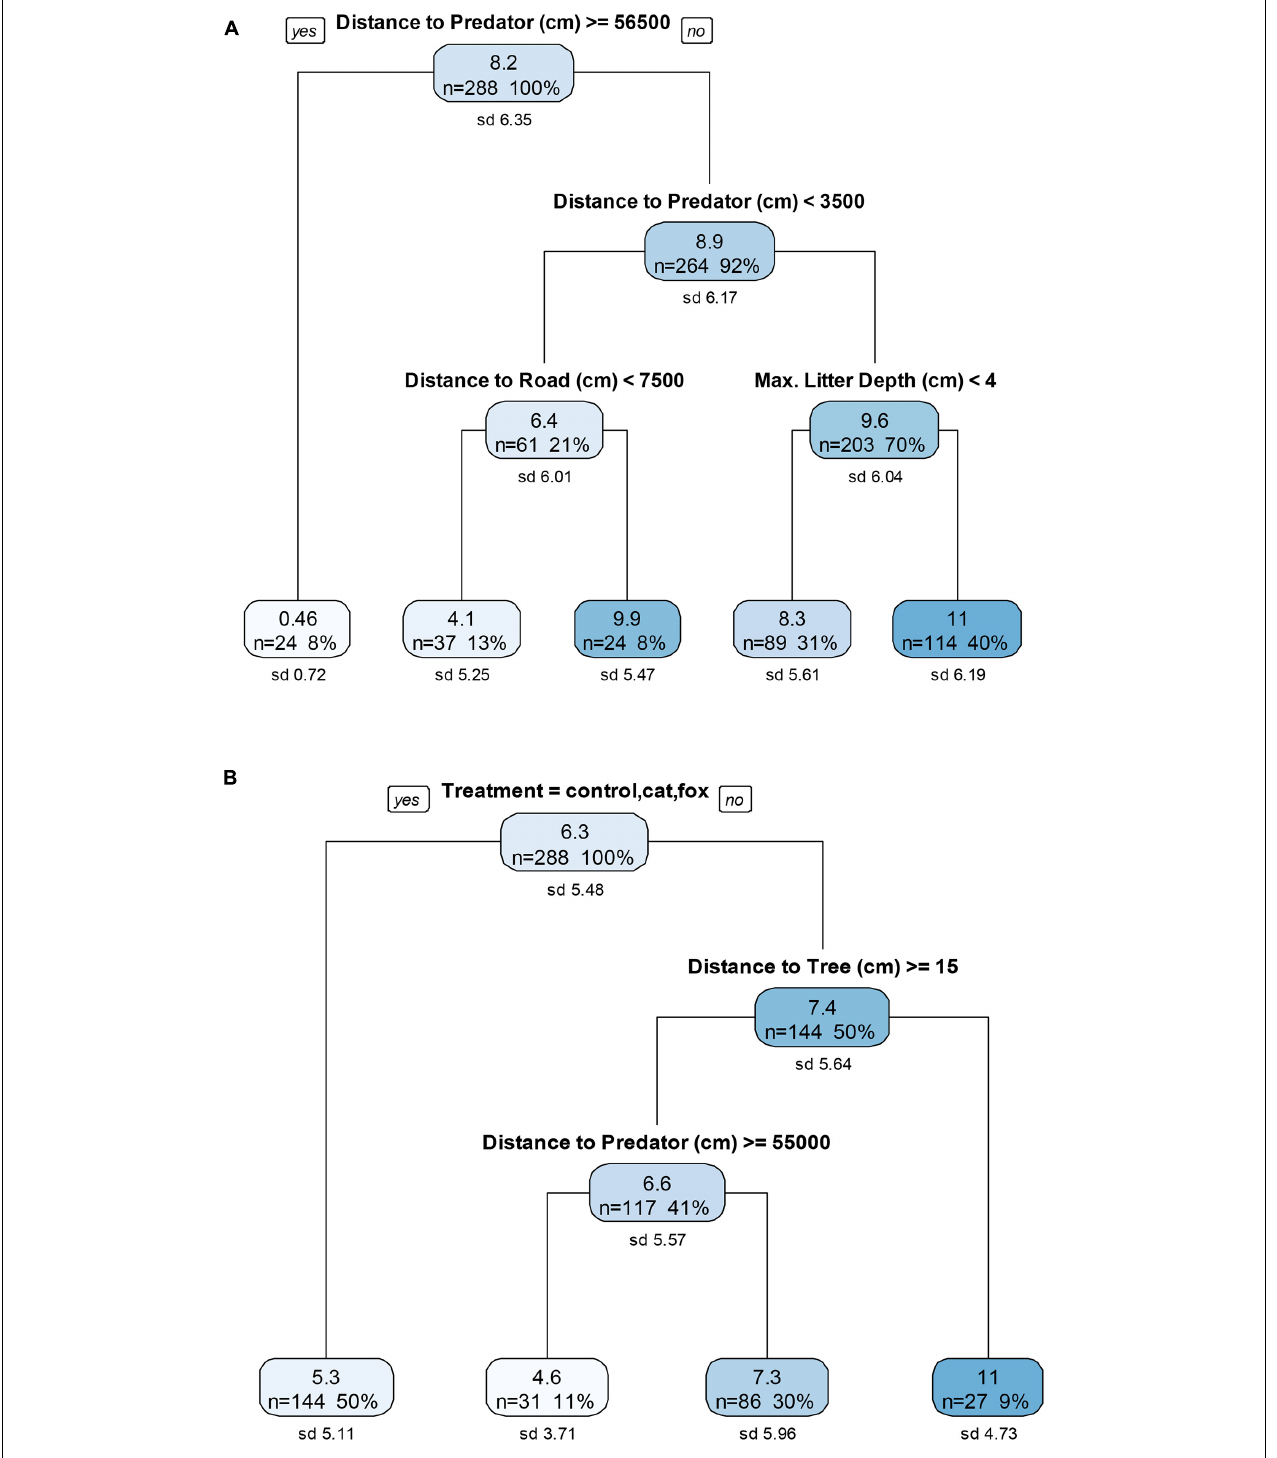
FIGURE 4 | Descriptive regression decision trees for four sessions of three nights each of (A) pre-treatment and (B) treatment giving-up density (GUD) trials at the mid environment, a remnant forest on undeveloped heavily vegetated state-owned land on the edge of a conservation area. The top number in each node is the GUD, the mean number of mealworms left in the tray (after ∼ 12 h nocturnal exposure). The number of GUD station surveys included in the data split at each node is given by the “ n ” number. The “%” value is its corresponding percentage from the full data set ( n = 288). The standard deviation of the mean number of mealworms left at each node is given by the “sd” value. The six treatments in (B) included: control, domestic cat cue, red fox cue, human disturbance cue (sound and light), and combined human disturbance and cat or fox cues.